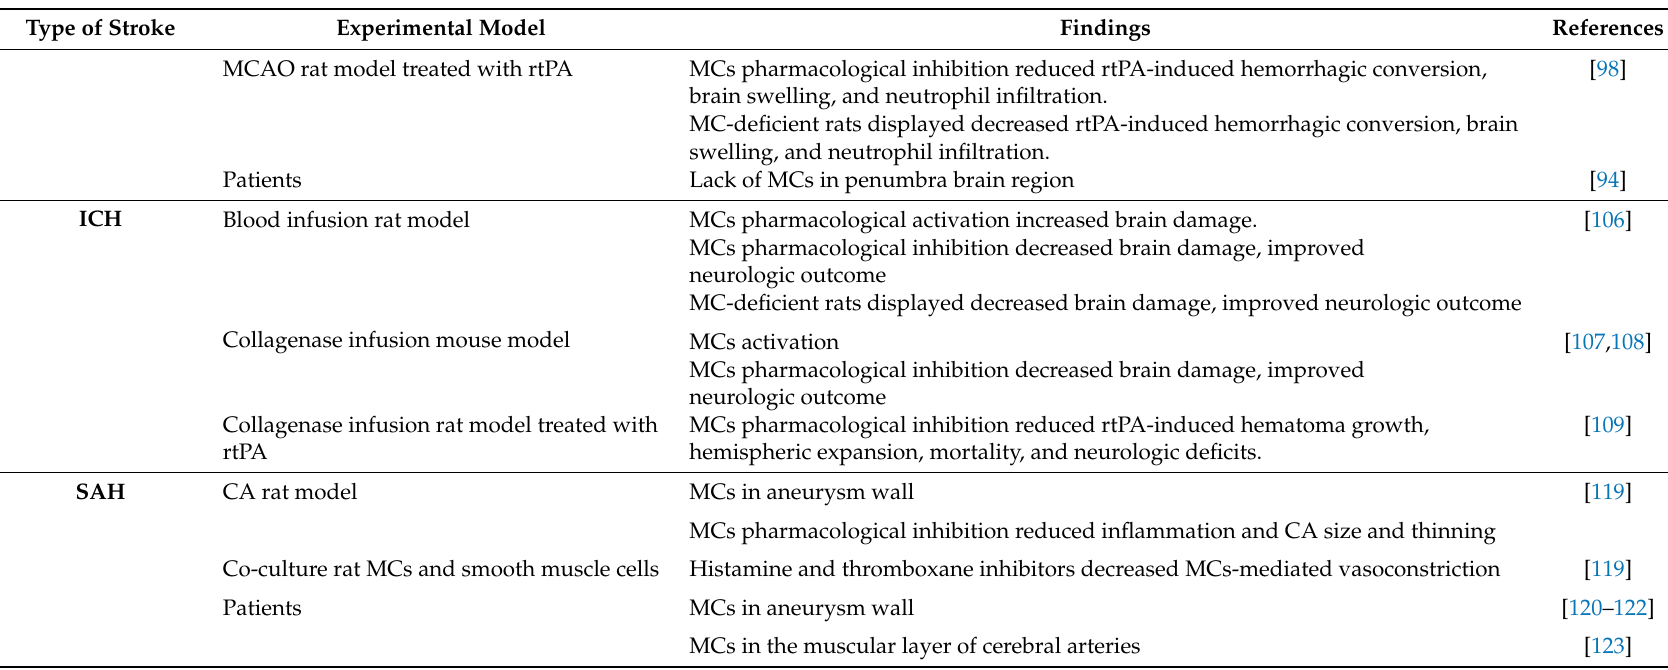
Type of Stroke Experimental Model